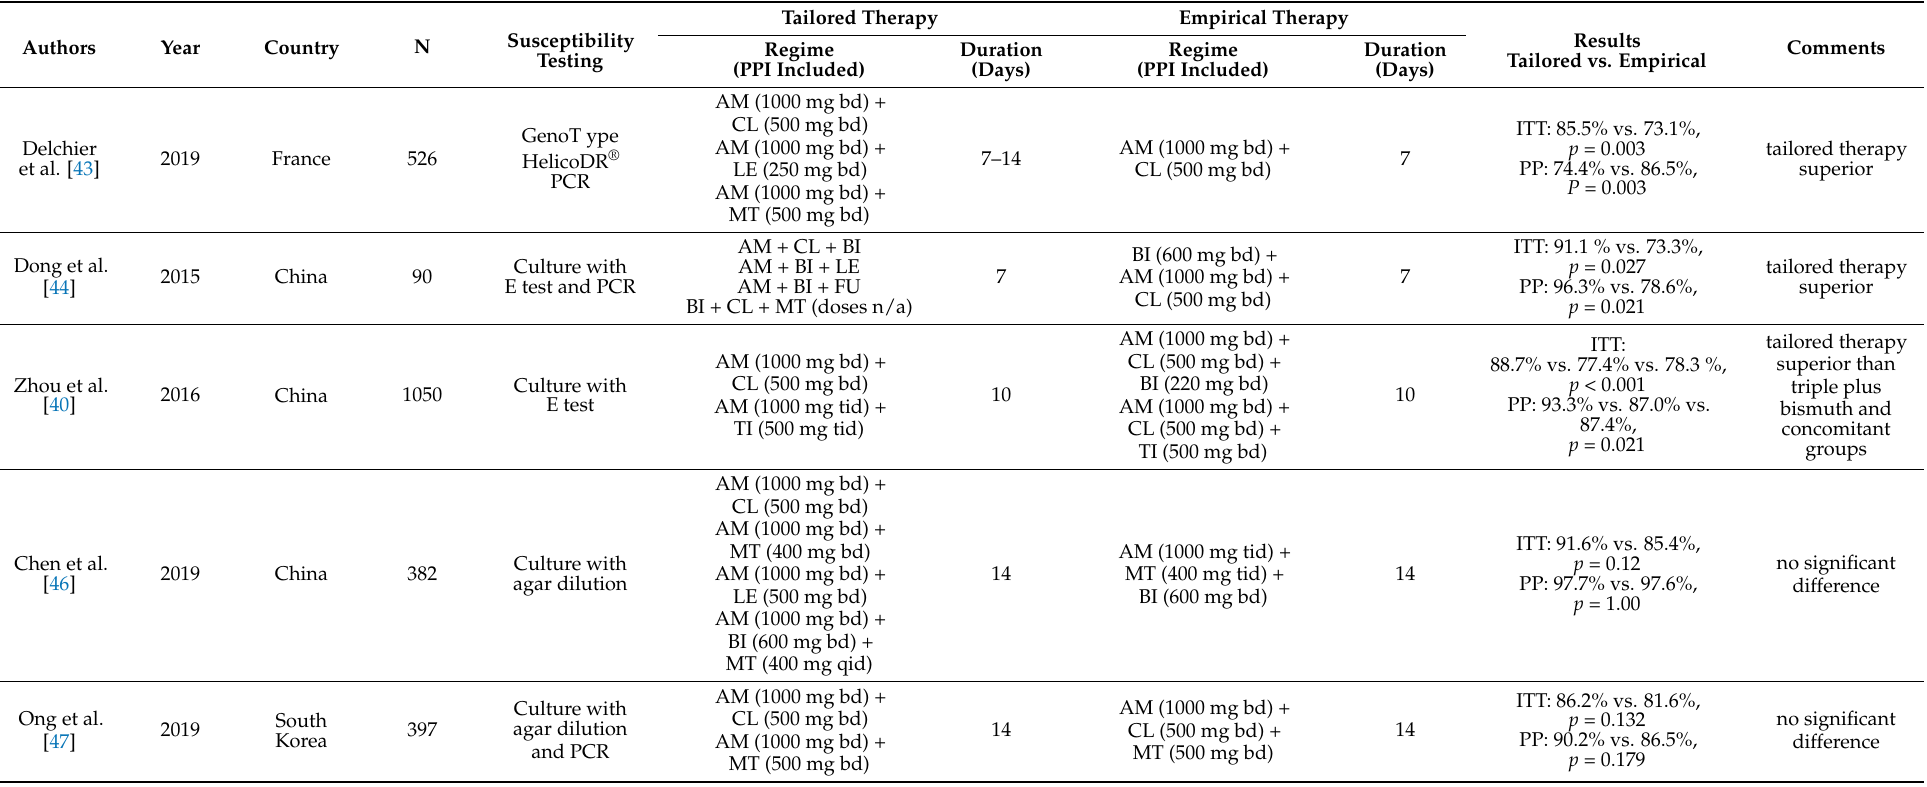
Table A1. Randomized clinical trials comparing tailored and empirical